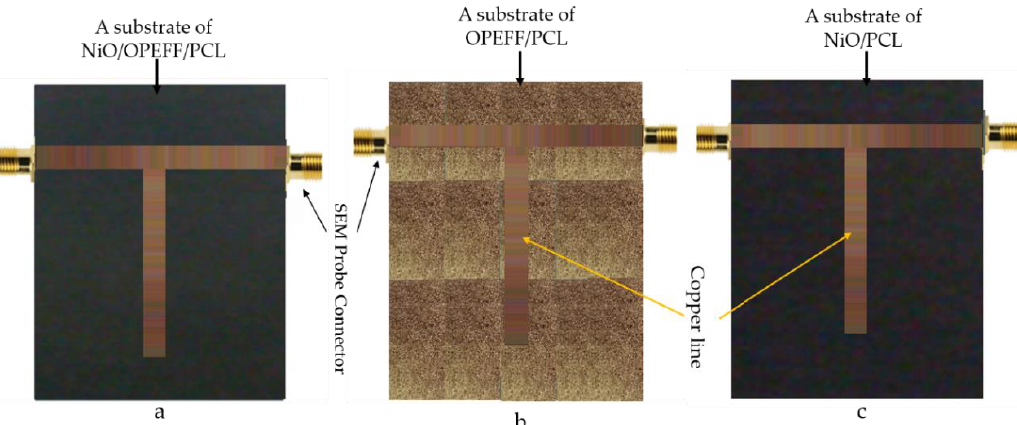
Figure 3. Manufactured structure of T-junctions ( a ) NiO / OPEFF / PCL, ( b ) OPEFF / PCL, and ( c ) NiO / PCL based on the fabricated substrates.